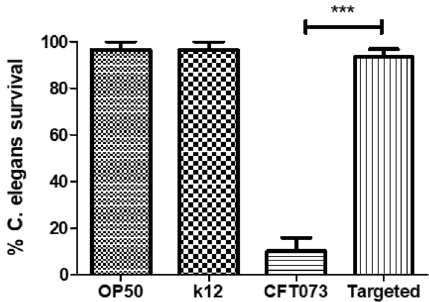
Figure 6. CFT073 mediated C. elegans killing assay. Percentage survival of C. elegans is represented against OP50, K12, CFT073 and Cri-dots-papG CFT073 isolates. Data are presented as mean ± SEM of 3 independent experiment.